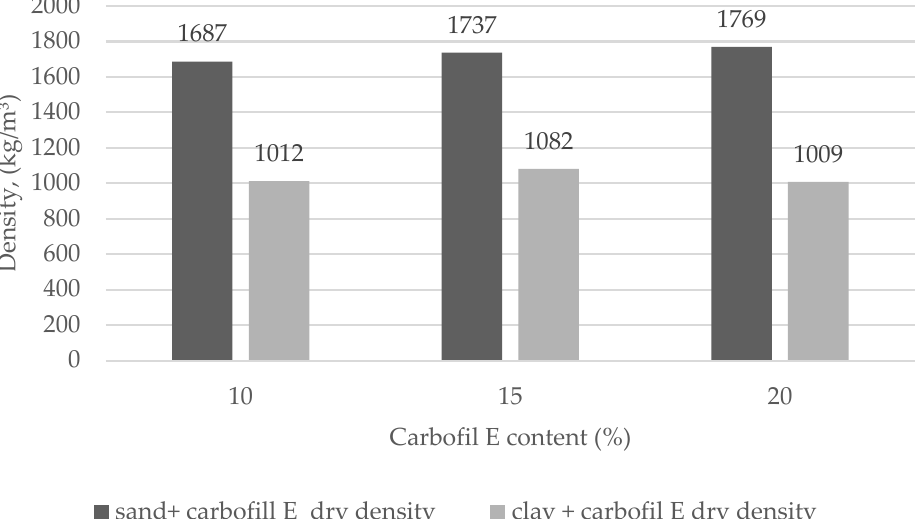
Figure 4. Density of SCS with sandy and clay soils corresponding to the amount of Carbofill E binder. The water permeability of hardened SCS with sandy and clay soils is shown in Figure 5. The coefficient of permeability of SCS mixed with sand and 10 %, 15%, 20% Carbofill E was found to vary between 4.28 × 10 − 8 m/s and 2.04 × 10 − 11 m/s, while the coefficient of permeability of SCS mixed with clay and 10 %, 15%, 20% Carbofill E was found to vary between 4.56 × 10 − 10 m/s and 3.84 × 10 − 10